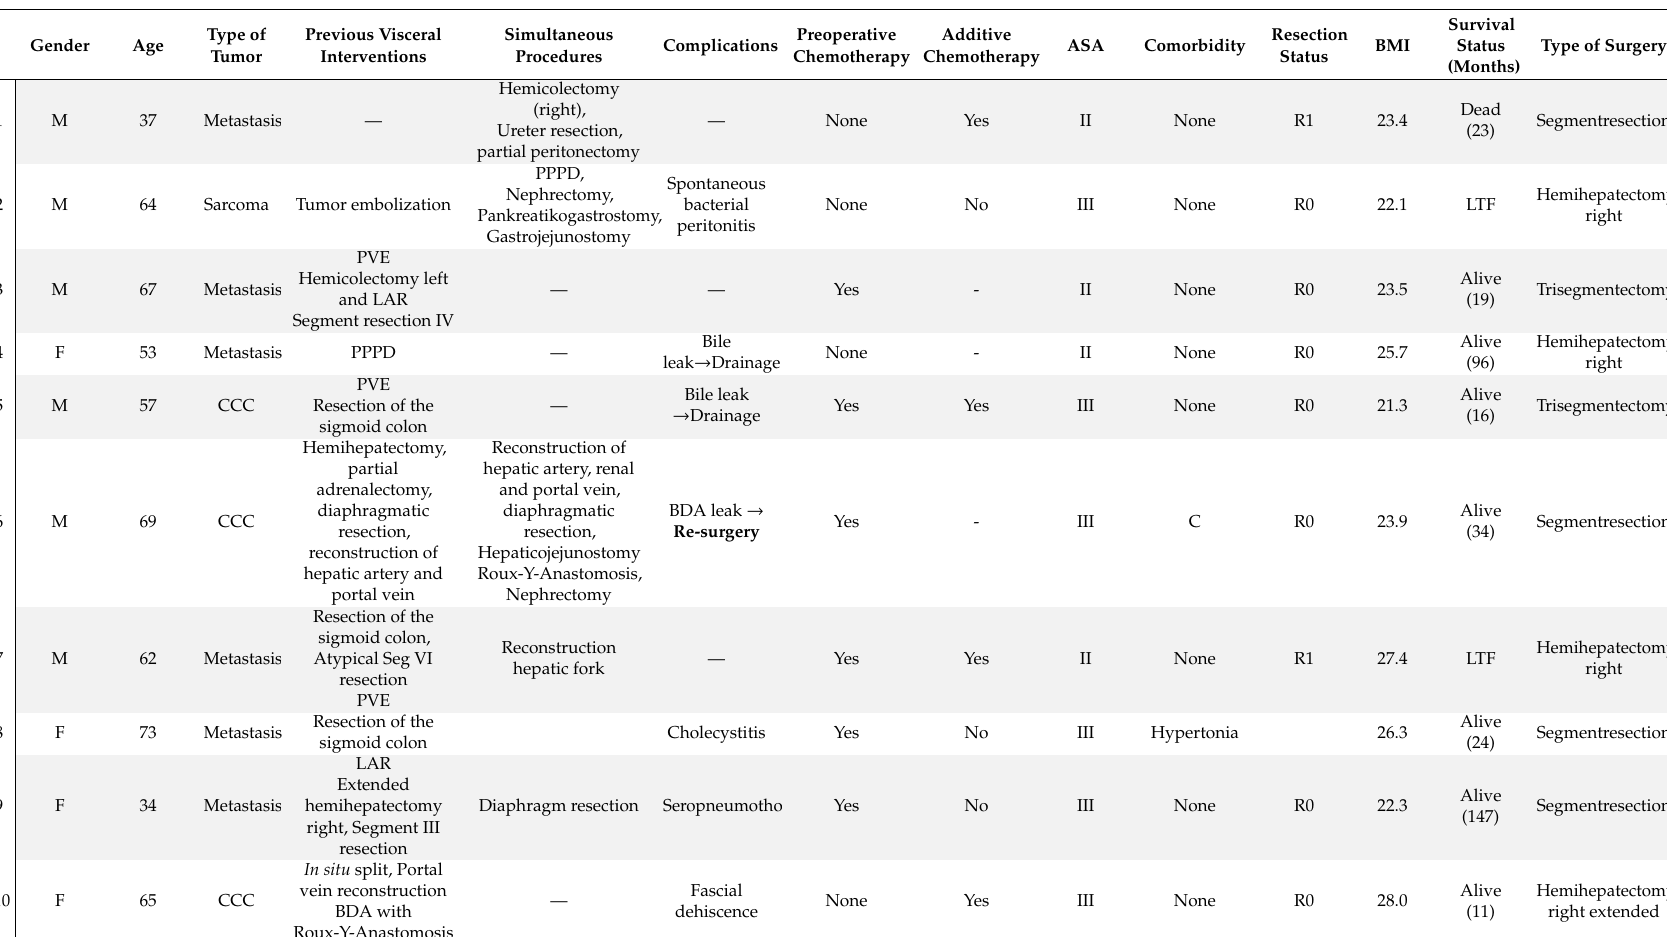
Table 1. Individual characteristics of the included patients. Epidemiological data as well as data about the type of procedure performed and the postoperative course are